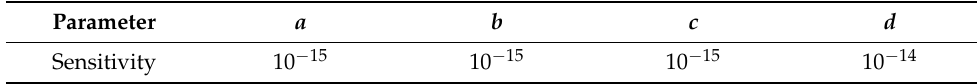
Table 1. Key sensitivity Table 2. Key sensitivity test.